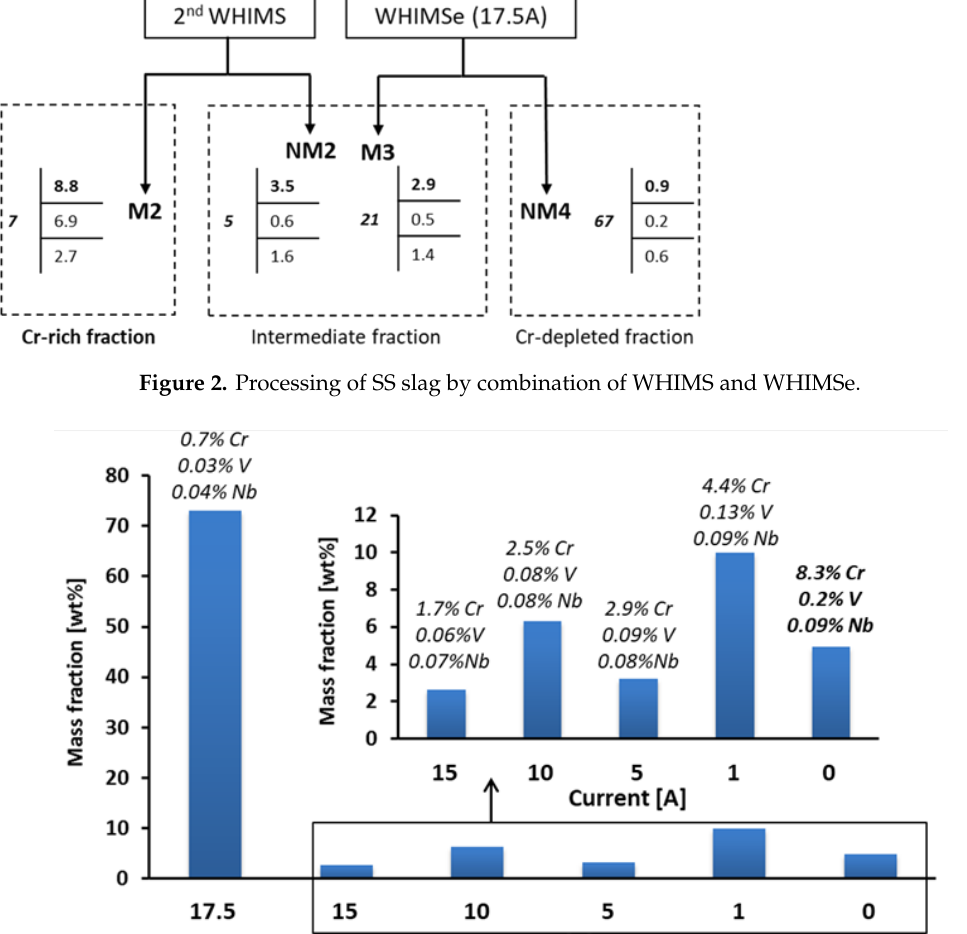
Figure 2. Processing of SS slag by combination of WHIMS and WHIMSe.